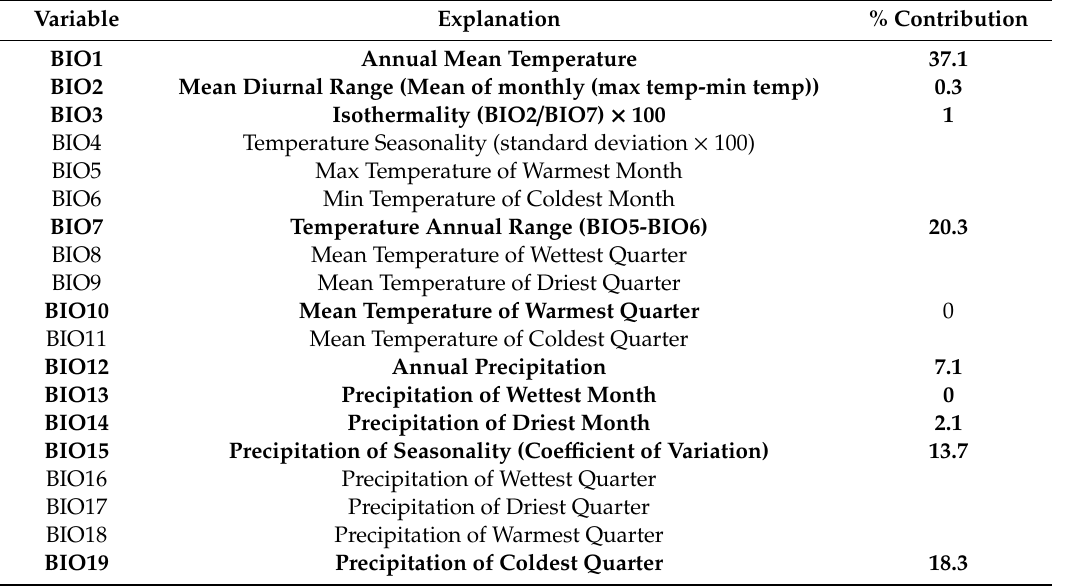
Table 1. Available and used (bold) bioclimatic variables for modeling of the present and future potential suitable habitat of M. walkerae . The percent contribution of each of the low correlated variables to the present potential suitable habitat model is also